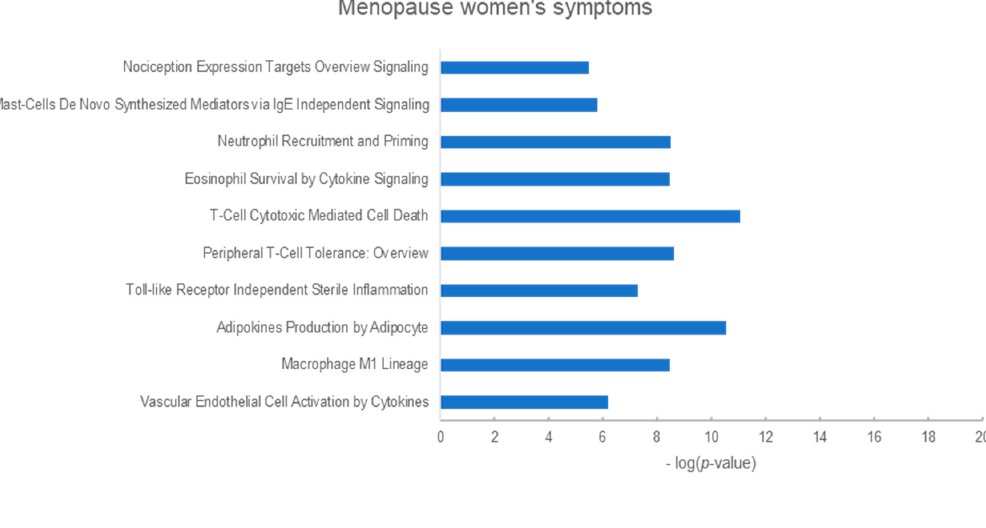
Figure 3. Cont ( a )